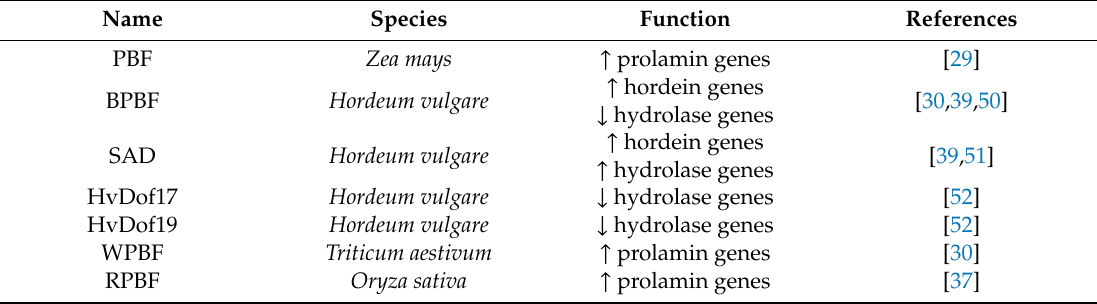
Table 1. DOF (DNA binding with one finger) genes involved in seed storage protein accumulation and